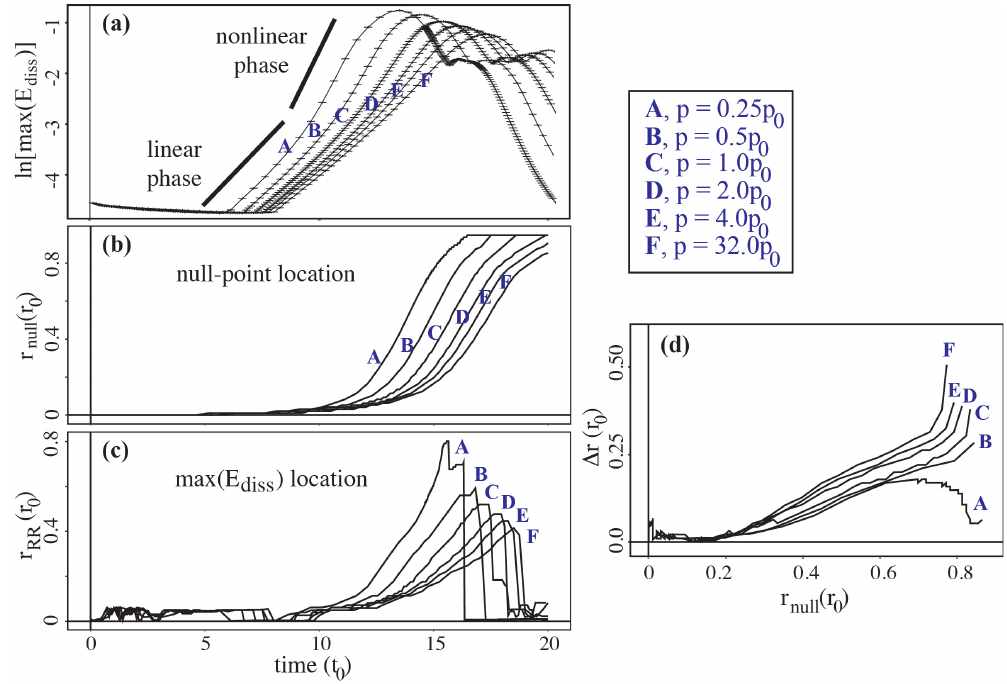
Fig. 9. Time traces of (a) the maximum magnitude of normalized dissipation electric field max (E diss ) ; (b) the radial position of the magnetic null-point r null and (c) the radial position of the location of maximum dissipation E -field r RR for the six single-fluid simulations with varying plasma β . Panel (d) shows the radial distance 1r ≡ (r null − r RR ) versus the null-point’s radial position r null